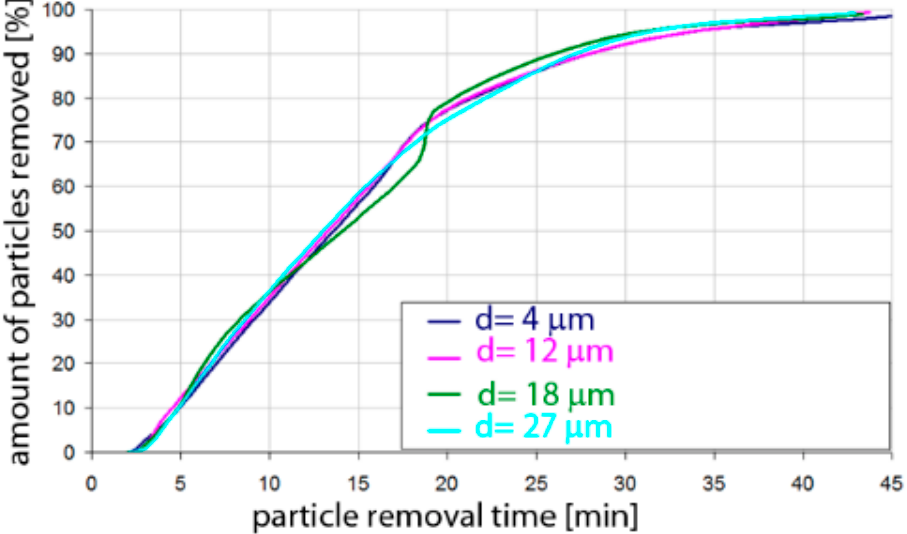
Figure 16. Share of removed non-metallic MnS inclusions in the analysed ladle in the case of argon flow of 25 L/min through the 18CrNiMo7-6 steel.